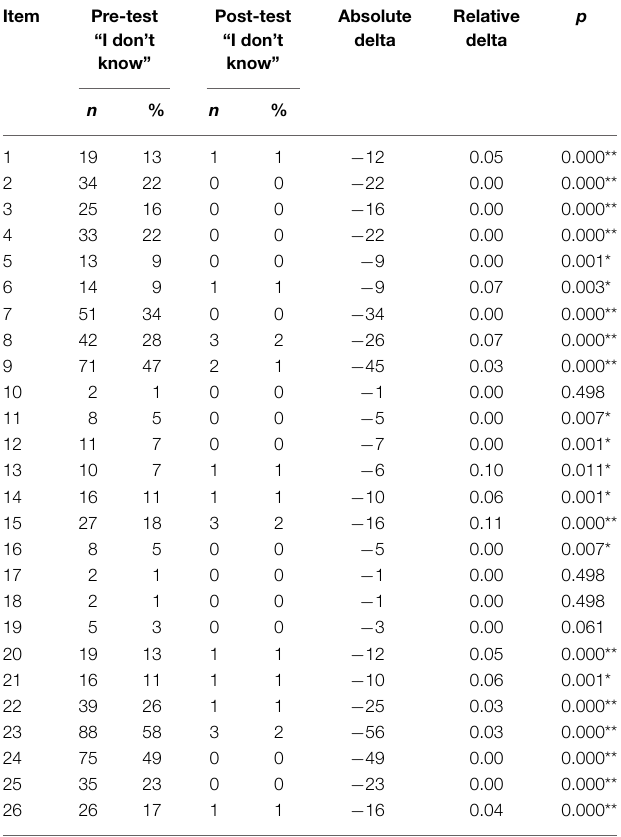
TABLE 5 | Differences between pre- and post-test “I don’t know” responses on the Knowledge Questionnaire of Adolescent Depression for School Staff .